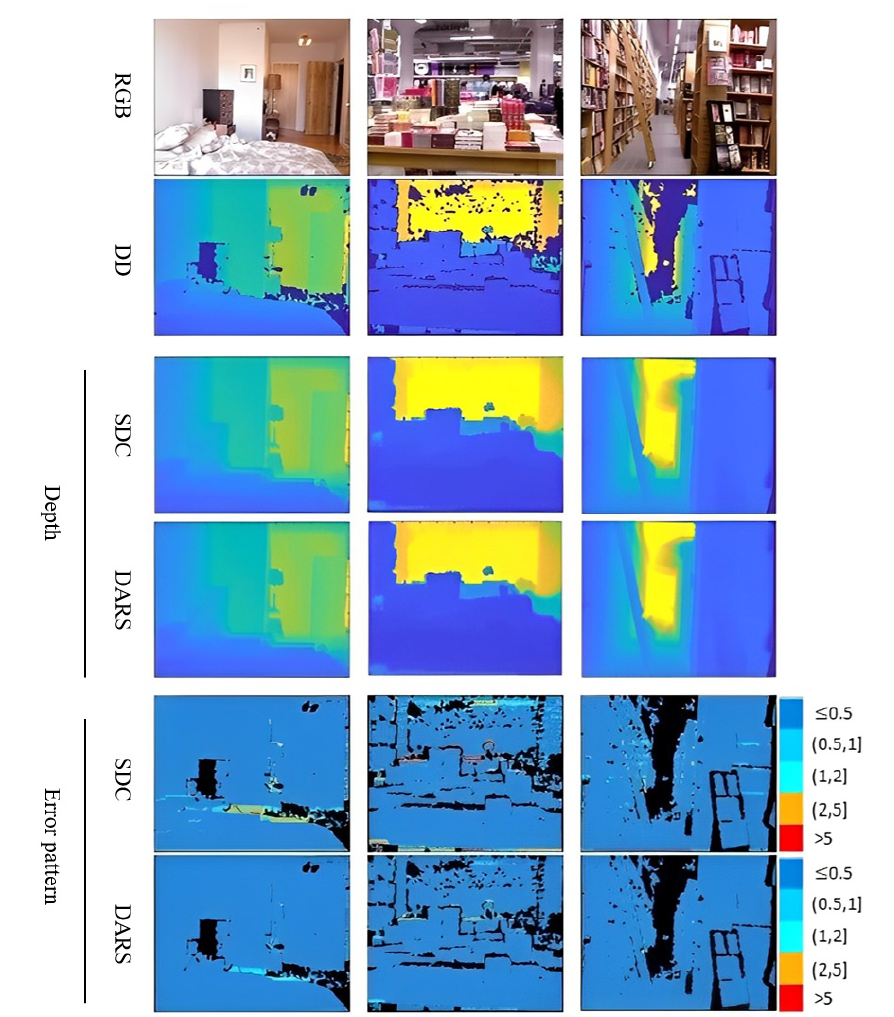
Figure 8. Visual results related to ablation study of NYUv2 dataset. Numbers on the right side of error patterns are in